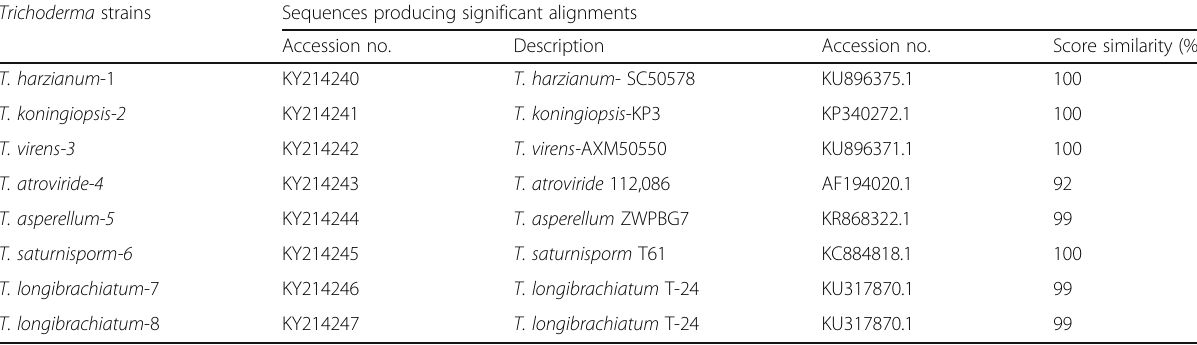
Table 1 The sequences producing significant alignments among Trichoderma species Trichoderma strains Sequences producing significant alignments